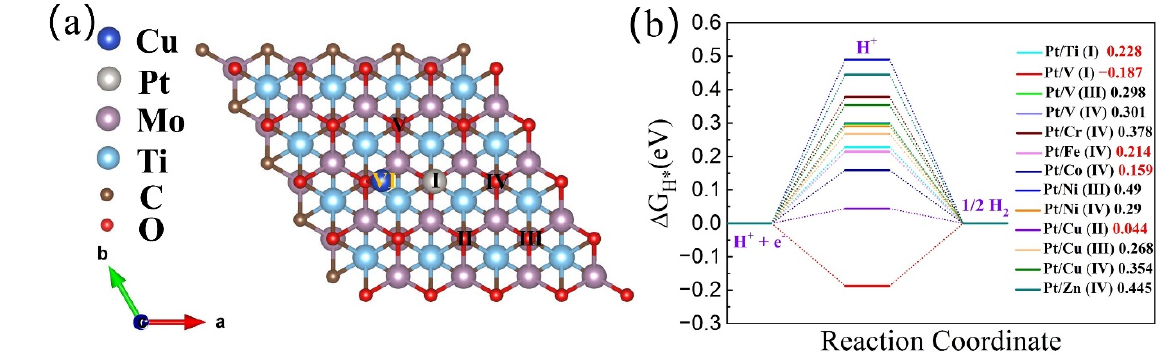
Figure 3. ( a ) Six possible H proton adsorption sites on the Pt/Cu@Mo 2 TiC 2 O 2 h-DACs’ surface, i.e., Site I, Site II, Site III, Site IV, Site V, and Site VI. ( b ) Calculated Gibbs free energy profiles of HER at different sites for Pt/TM@Mo 2 TiC 2 O 2 h-DACs (TM = Ti, V, Cr, Fe, Co, Ni, Cu, and Zn). The red numbers represent the catalysts with high HER catalytic activity. a, b and c are the three directional axes of the cell structure, respectively.